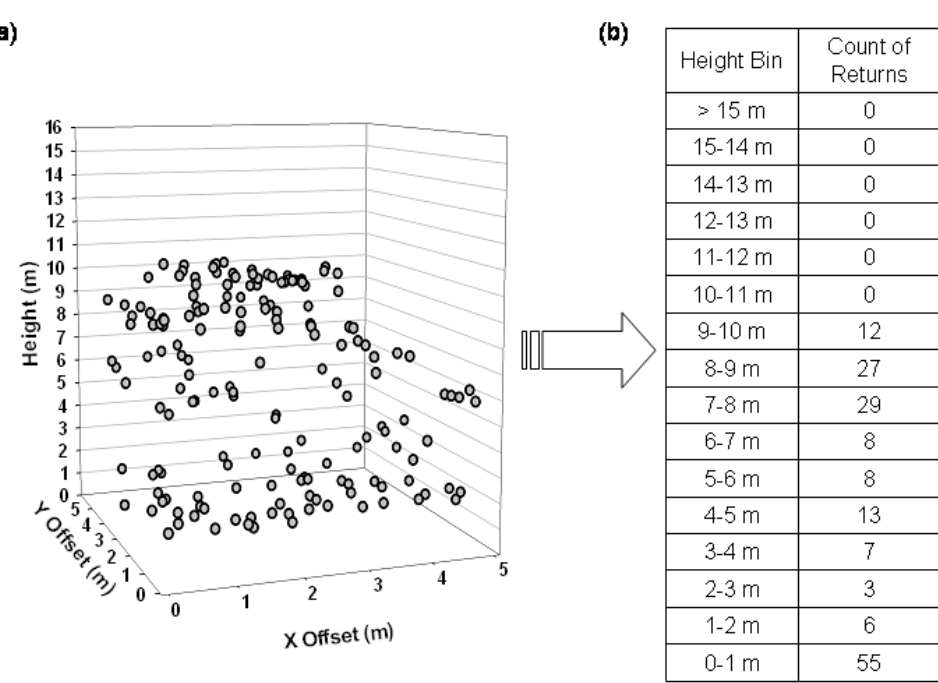
Figure 1. Creation of vertical height bins from the lidar point cloud data. (a) Three- dimensional profile of a 5 × 5 m cell within the study area, with grey circles representing vegetation points whose heights have been normalized using the bare-earth surface raster. (b) Multidimensional output data, showing the number of vegetation point returns occurring in each of the 1 m vertical height